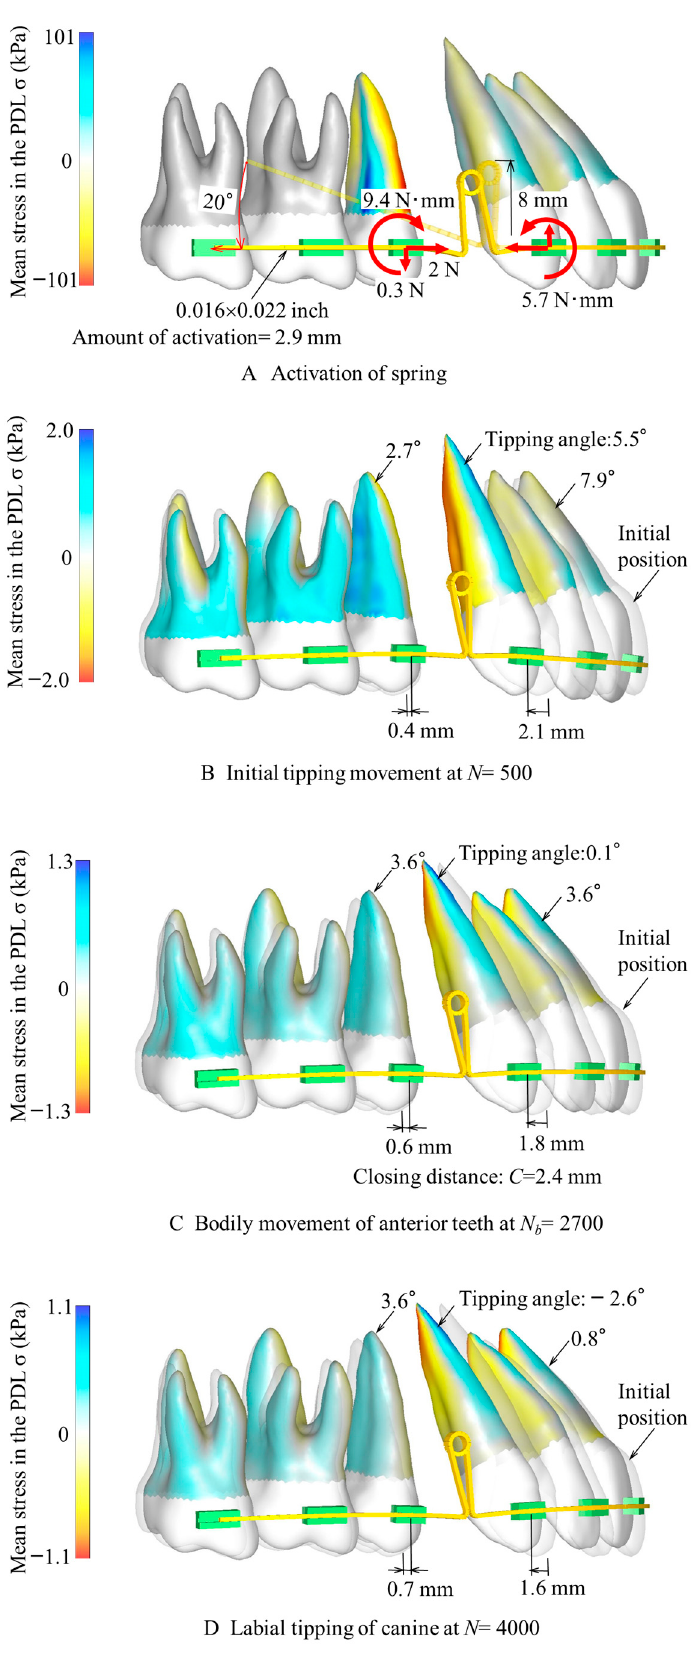
Figure 3. Tooth movement process with the helical loop spring. The anterior teeth first tip, then become upright. At N b = 2700, the canine achieves bodily movement.